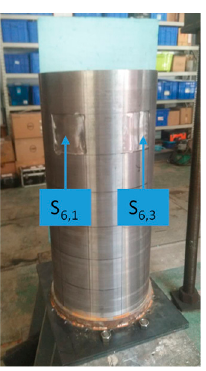
Figure 18. Single damage of the tank model. Appl. Sci. 2020 , 10 , x FOR PEER REVIEW